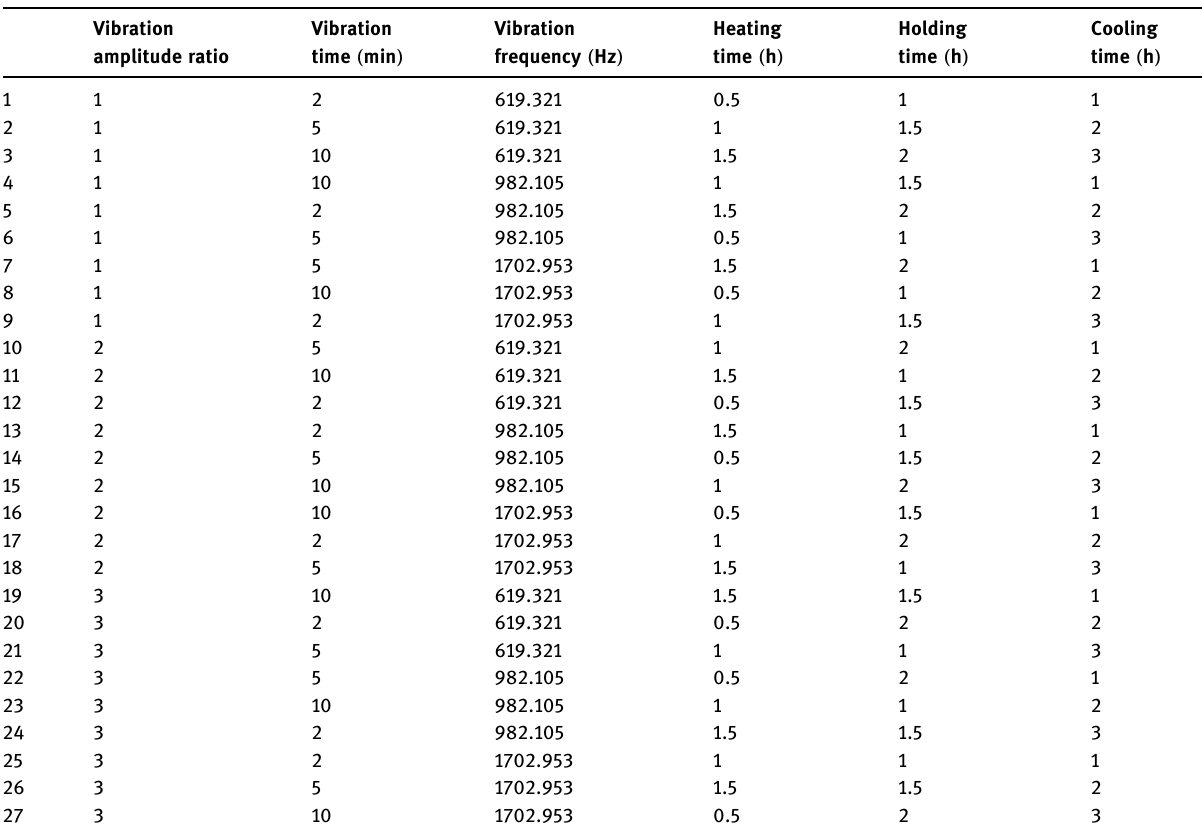
Table 3: Orthogonal test of process parameters of TVSR